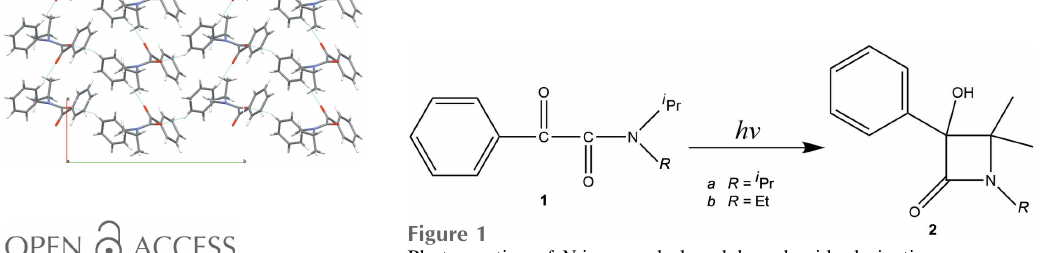
Figure 1 Photoreaction of N -isopropyl-phenylglyoxylamide